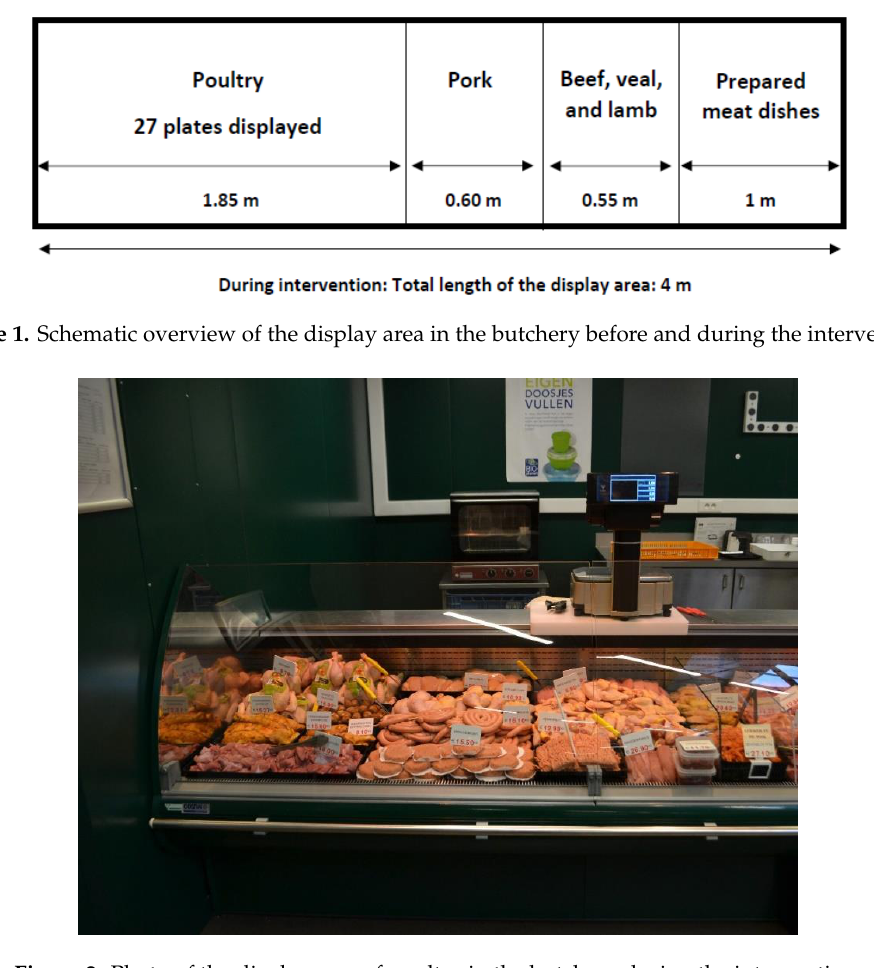
Figure 2. Photo of the display area of poultry in the butchery during the intervention.